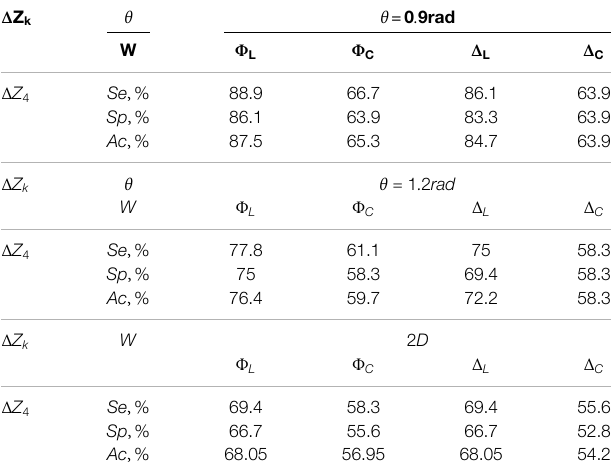
TABLE 4 | Operational characteristics of the diagnostic performance of the 3D Mueller-matrix reconstruction method of optical anisotropy of myocardial histological